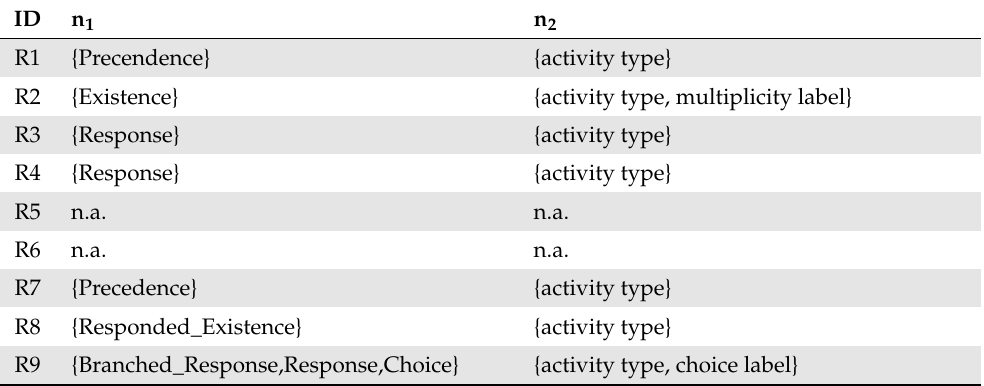
Table A5. Definitions on DECLARE.